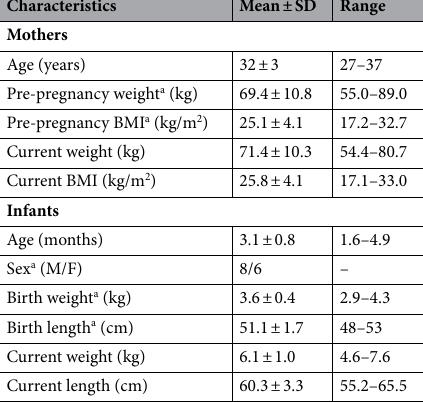
Table 1. Demographic characteristics of participating mothers and infants a . BMI body mass index, F female, M male, SD standard deviation. a Missing information from one participant.